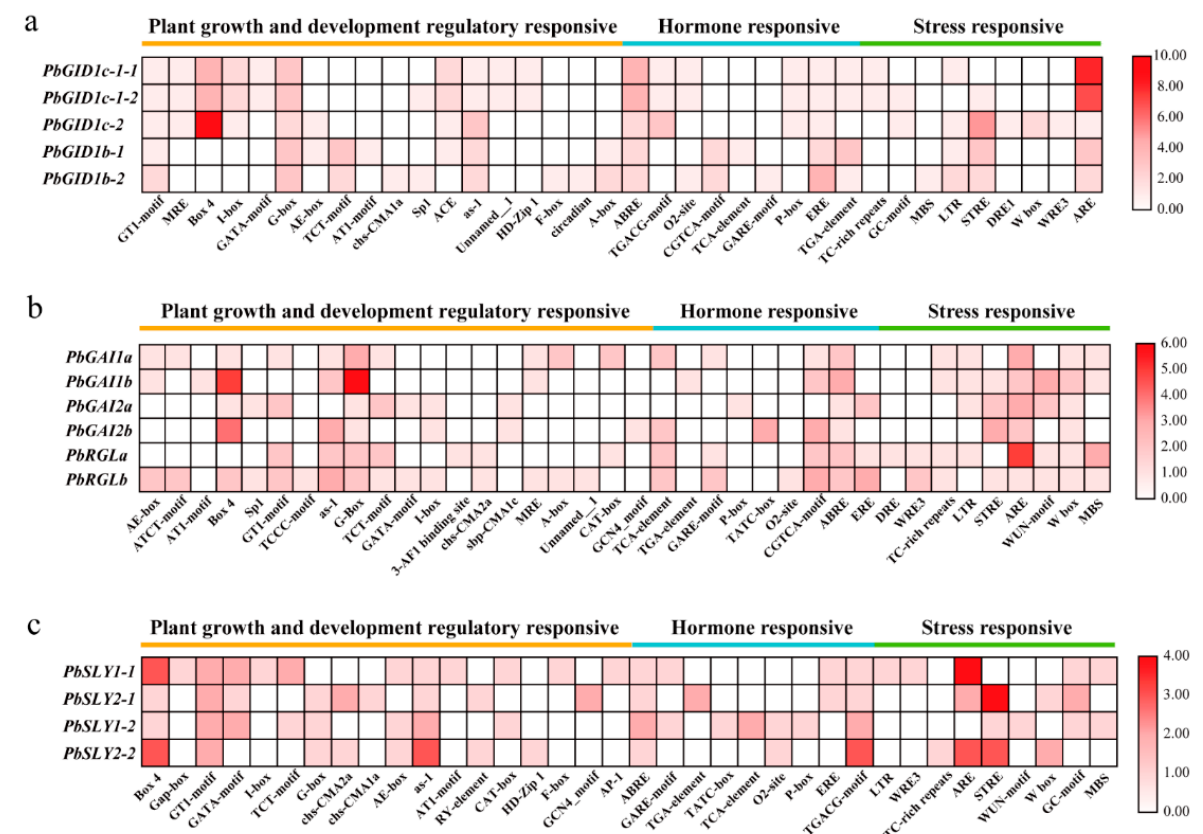
Figure 5. The cis -acting elements identified in the promoter regions of PbGID1s , PbDELLAs , and PbSLYs of ‘ duli ’ pear ( Pyrus betulifolia Bunge). ( a ) The cis -acting elements in the promoter region of PbGID1s . ( b ) The cis -acting elements in the promoter region of PbDELLAs . ( c ) The cis -acting elements in the promoter region of PbSLYs . The types (bottom of the charts) and numbers (bars on the right) of cis -acting elements in the 2000 bp upstream of the transcriptional start codon are shown in the heatmap.